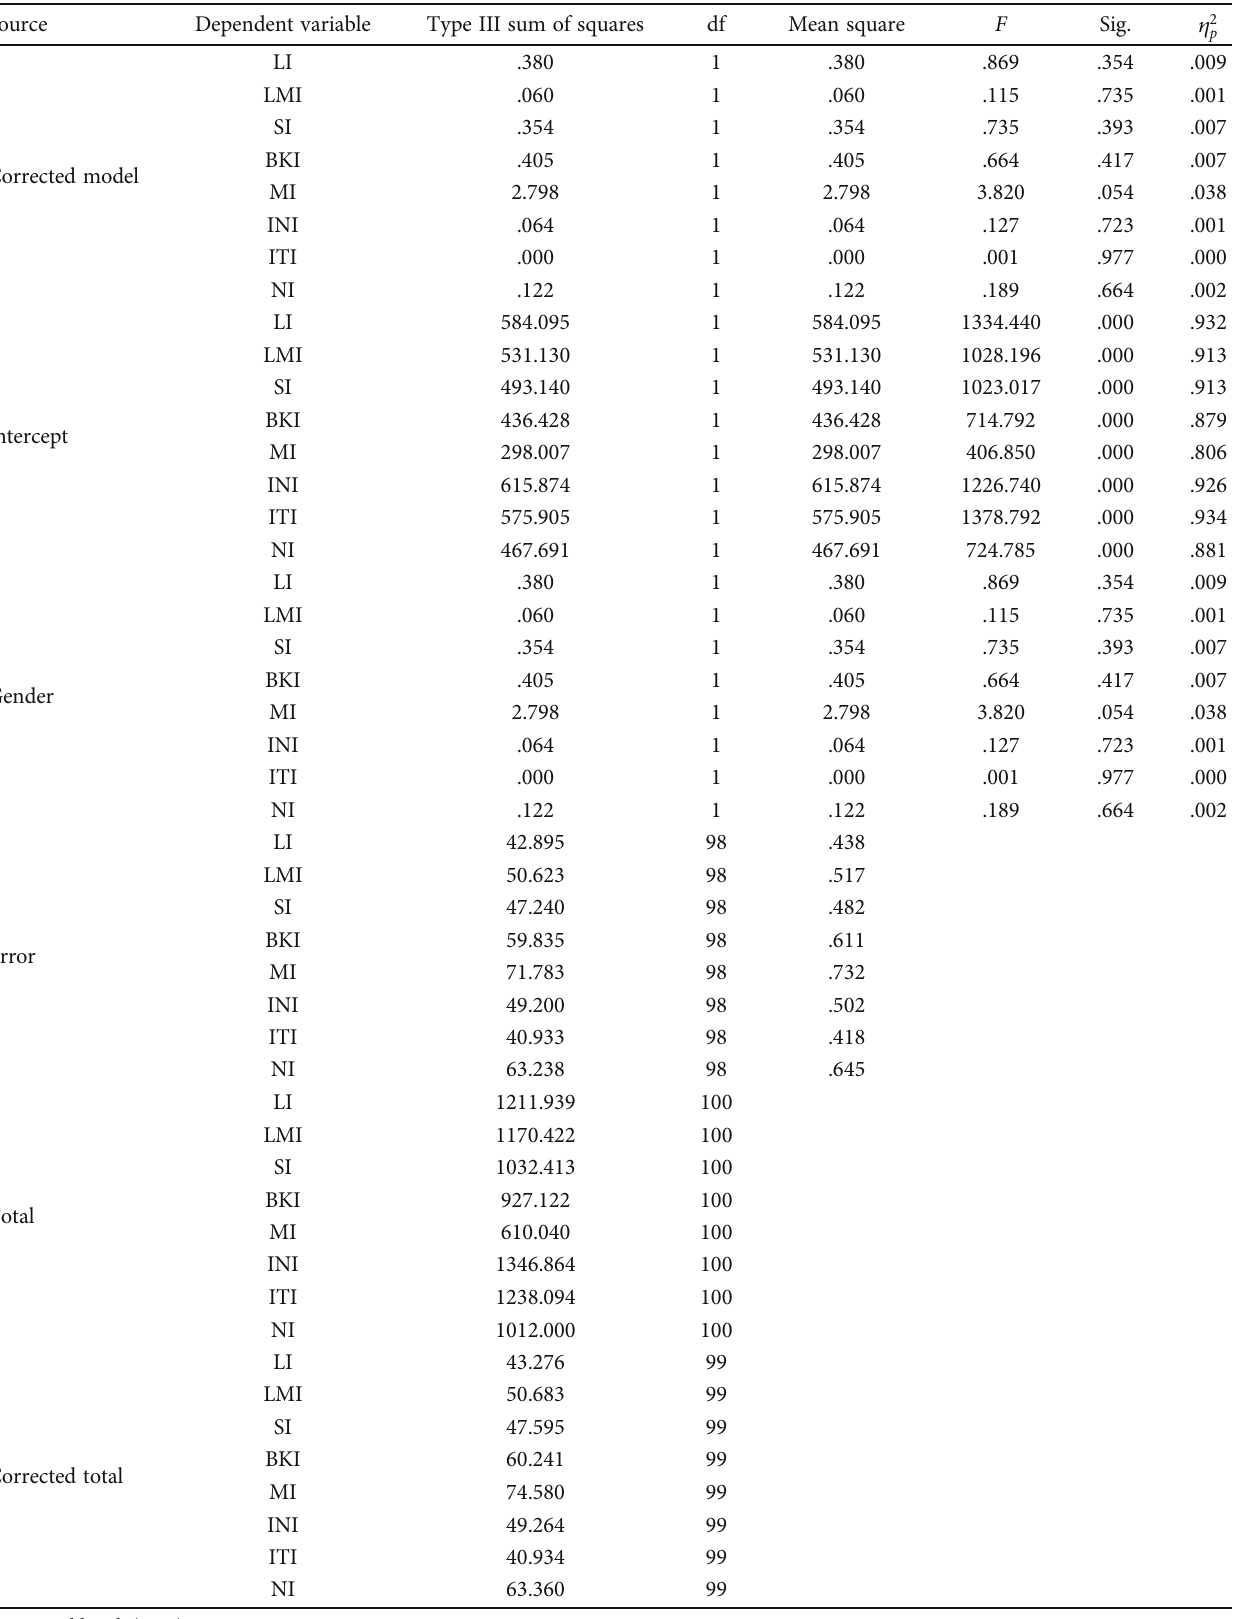
Table 7: Tests of between-subjects e ff